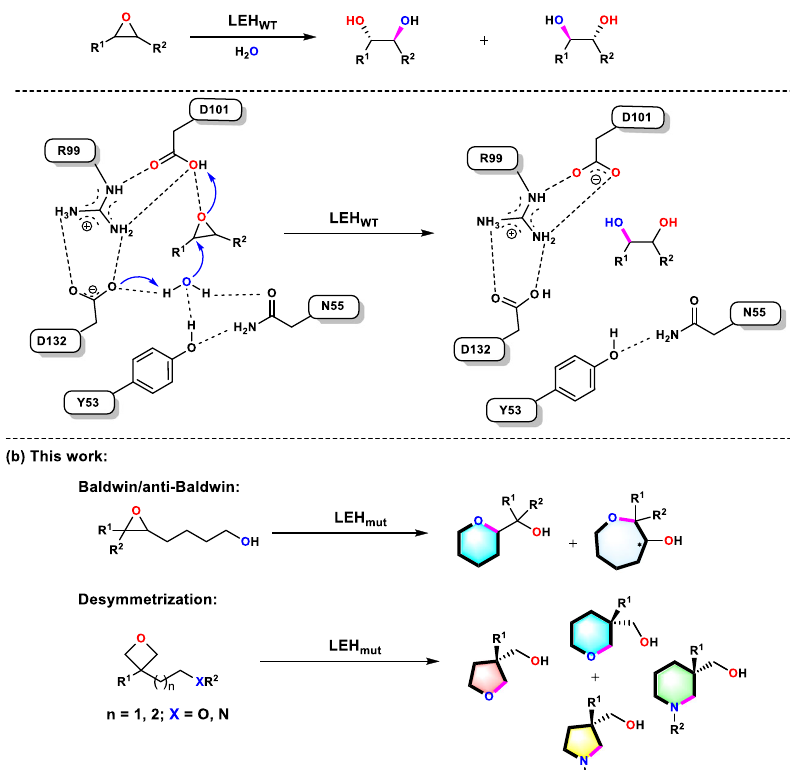
Fig. 1 | Schematic representation of LEH-catalyzed reactions. a Natural hydro- lytic reaction catalyzed by wild-type (WT) Re LEH (top) and its known catalytic mechanism (bottom) 23 ; D, Aspartic acid; N, Asparagine; Y, Tyrosine. b